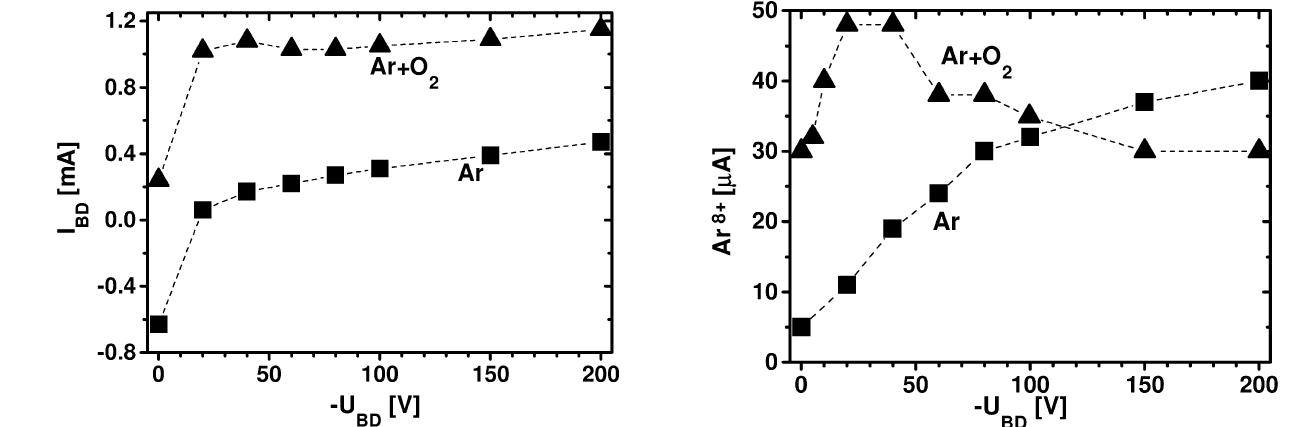
FIG. 1. Biased-disk currents as a function of the disk voltage for the case of plasmas of pure argon (squares) and Ar 1 O 2 gas mixing plasmas (triangles).